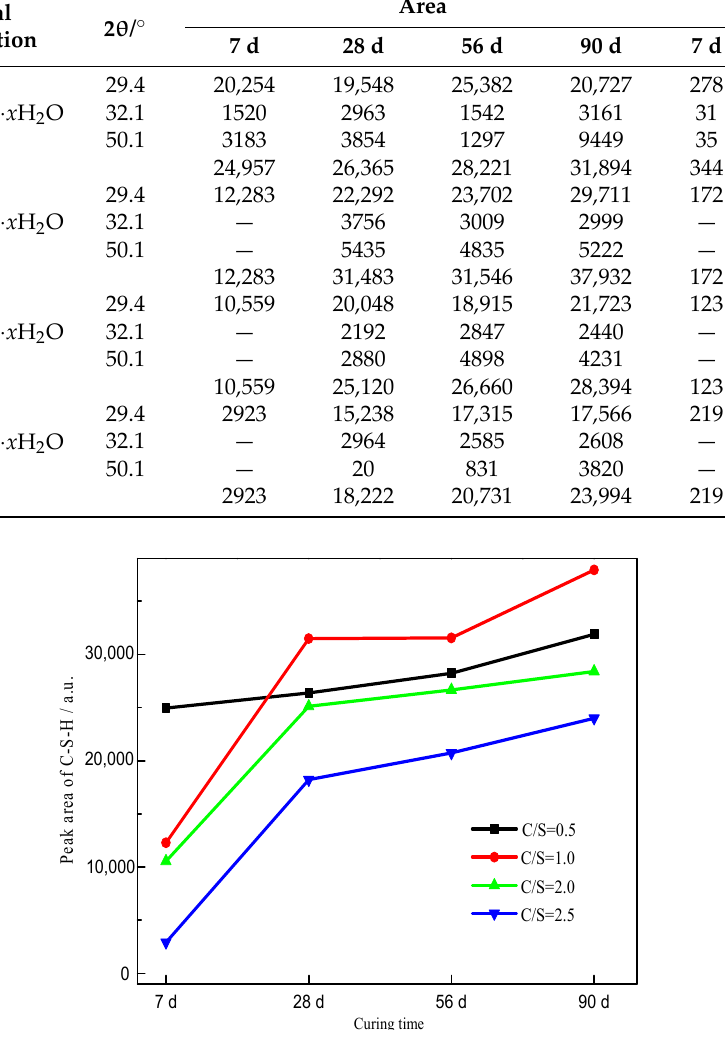
Figure 8. Peak areas of C-S-H in different samples.